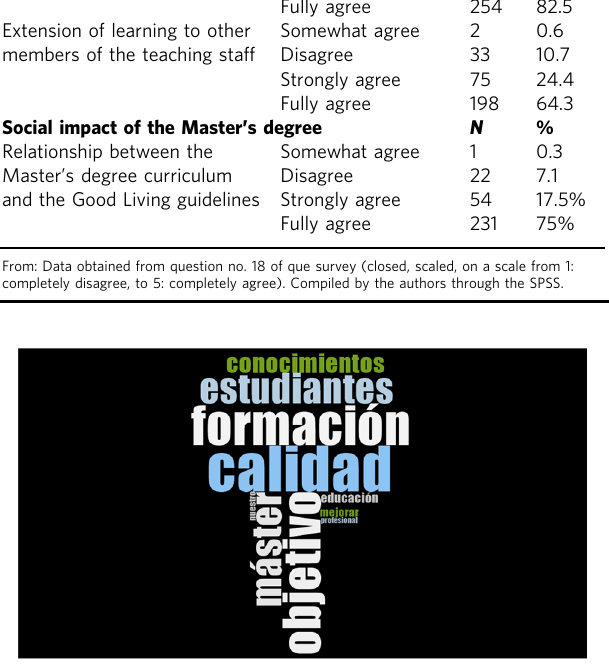
Fig. 5 Evaluation of the training received. From: Data obtained from question no. 16b from the survey (open type). Tag cloud. Compilated by the authors based on the information provided by the software Nvivo. The translation of the words from Spanish to English in descending order from highest to lowest is quality/training/students/knowledge/goal/master/